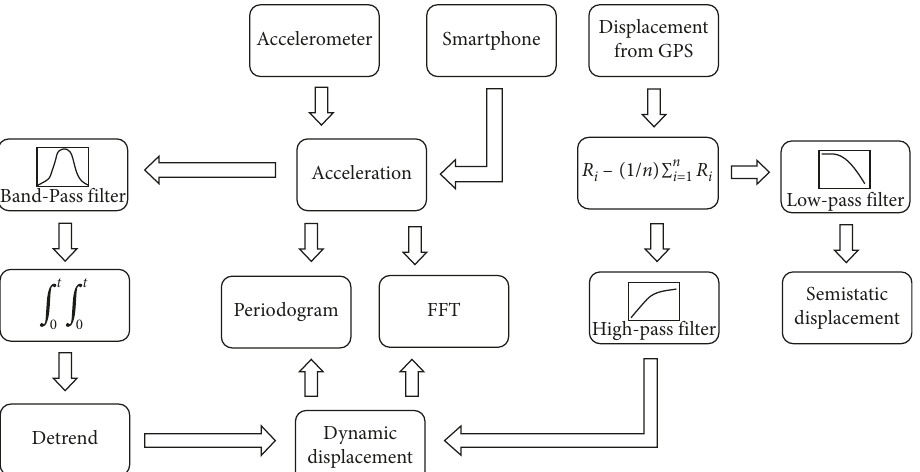
Figure 7: Flow chart of measurement